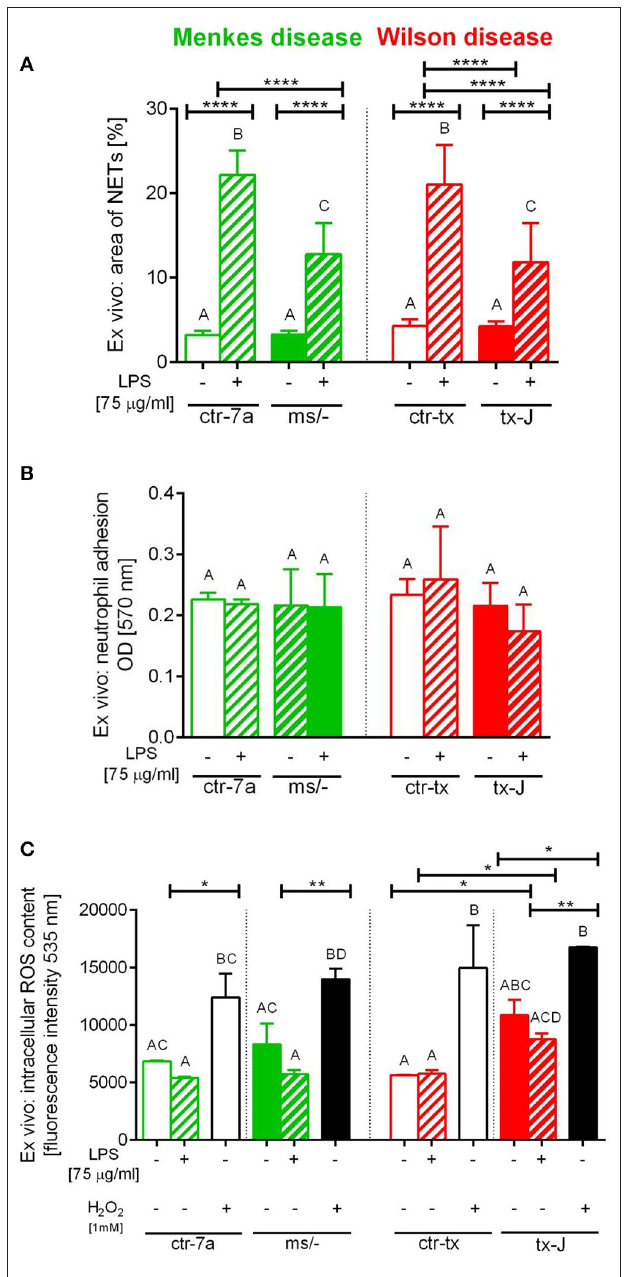
FIGURE 5 | Ex vivo studies on isolated bone marrow neutrophils of Wilson (tx-J) and Menkes ( ms / − ) disease mice and their respective controls (ctr-tx and ctr-7a) evaluating their capacity to form NETs (A) , adhere (B) , and release reactive oxygen species (ROS; C ). NET formation and capacity to adhere were evaluated 6h after stimulation with LPS, and the content of ROS was measured after the first hour (DCF-DA test). In (C) , white/black bars represent responses of cells treated with H 2 O 2 (positive control)—data for neutrophils from control mice (white bars) and mutants (black bars). Asterisks indicate significant differences using unpaired two-tailed Student’s t test (* P ≤ 0.05, ** P ≤ 0.01, **** P ≤ 0.0001) and one-way ANOVA ( post hoc Bonferroni) test (different letters indicate statistically significant differences between groups).